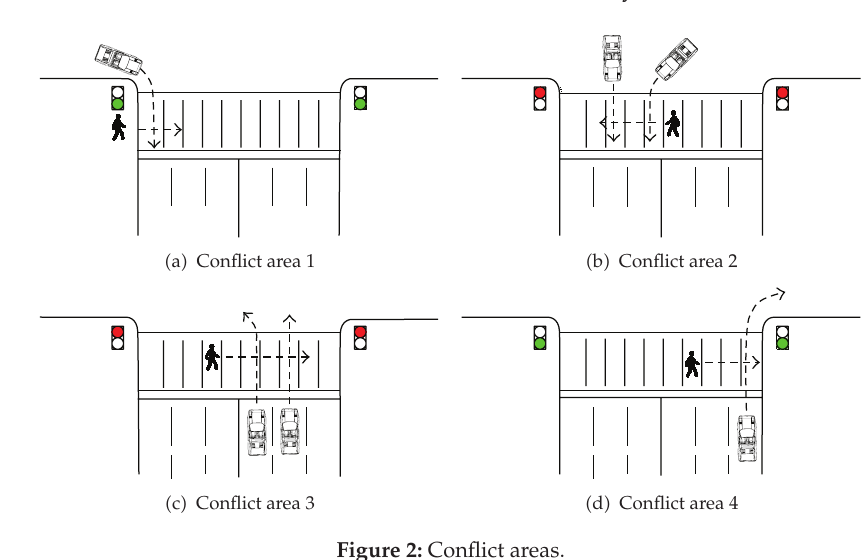
Figure 2: Conflict